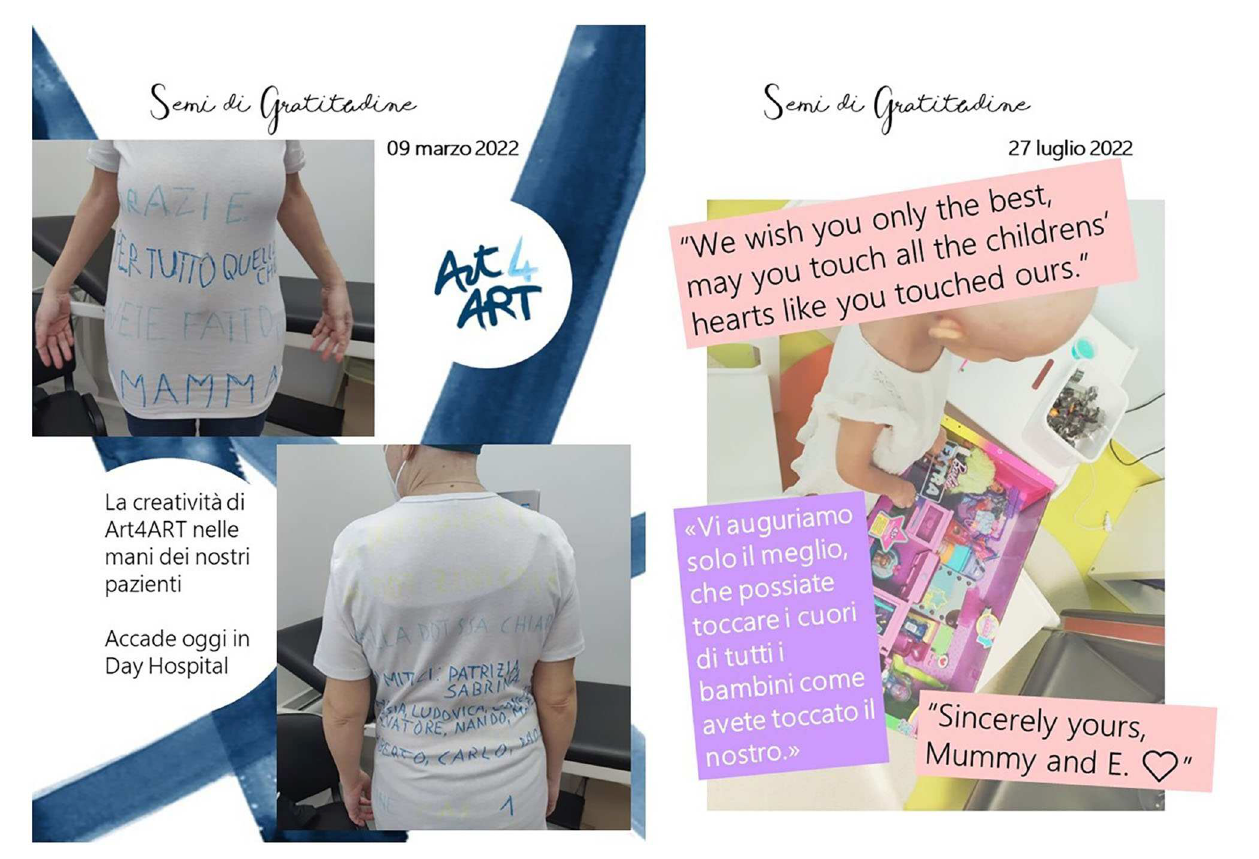
FIGURE4 CTwo of 180 “Seeds of Gratitude” realized for the broadcast. Translation of the “Seeds of Gratitude”: “thanks for what you did for mum”; “the Art4ART creativity in the hands of our patients, it happens today in day hospital”; “we wish you only the best, that you may touch the hearts of all children as you have touched